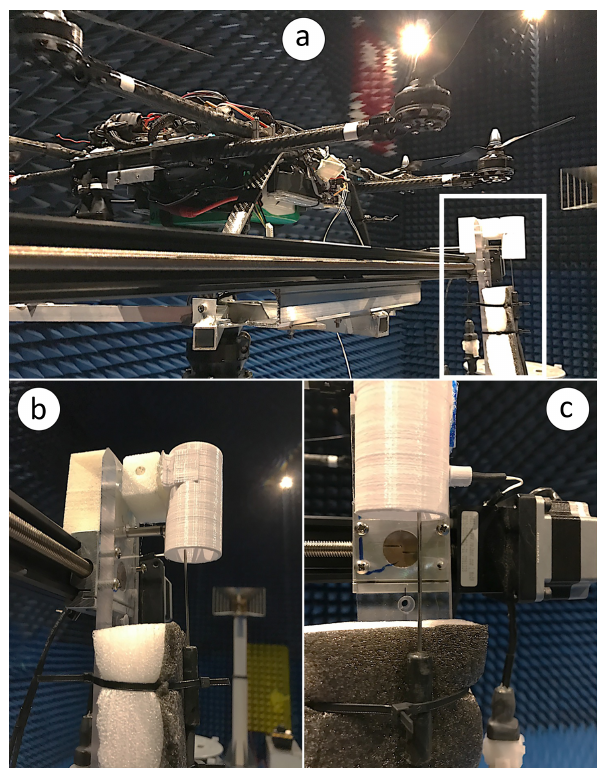
Figure 4. (a) Position of linear actuator arm underneath a rwUAS on mounting pedestal. Arm was aligned such that sensors passed directly underneath the motor mounts so as to make the system es- sentially two-dimensional. The sensor package is outlined in white. (b) Close-up side view of the sensor package. The NSSL thermistor (CS 109) is strapped vertically to a foam mount so that it reaches inside the solar shield (white cylinder) from the bottom. The hot- wire anemometer is attached to the linear actuator arm with a clear mount and passes into a hole on the back side of the solar shield. (c) Close-up front view of the sensor package. An iMet thermistor (PT 100) enters the solar shield through a hole on the right side. CS 109 also visible pointing